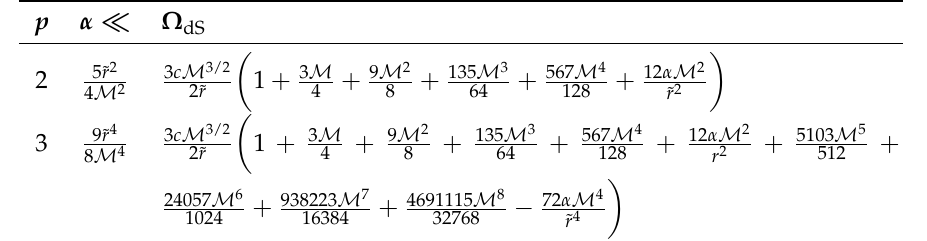
Table 1. Illustration of the α weak-field constraint depending on the index p for the f ( T ) model f ( T ) = T + α T p alongside the resulting Geodetic precession expressions based on the scalar functions A ( ˜ r ) and B ( ˜ r ) derived in References [93,94]. Here, we have defined the parameter M : = M